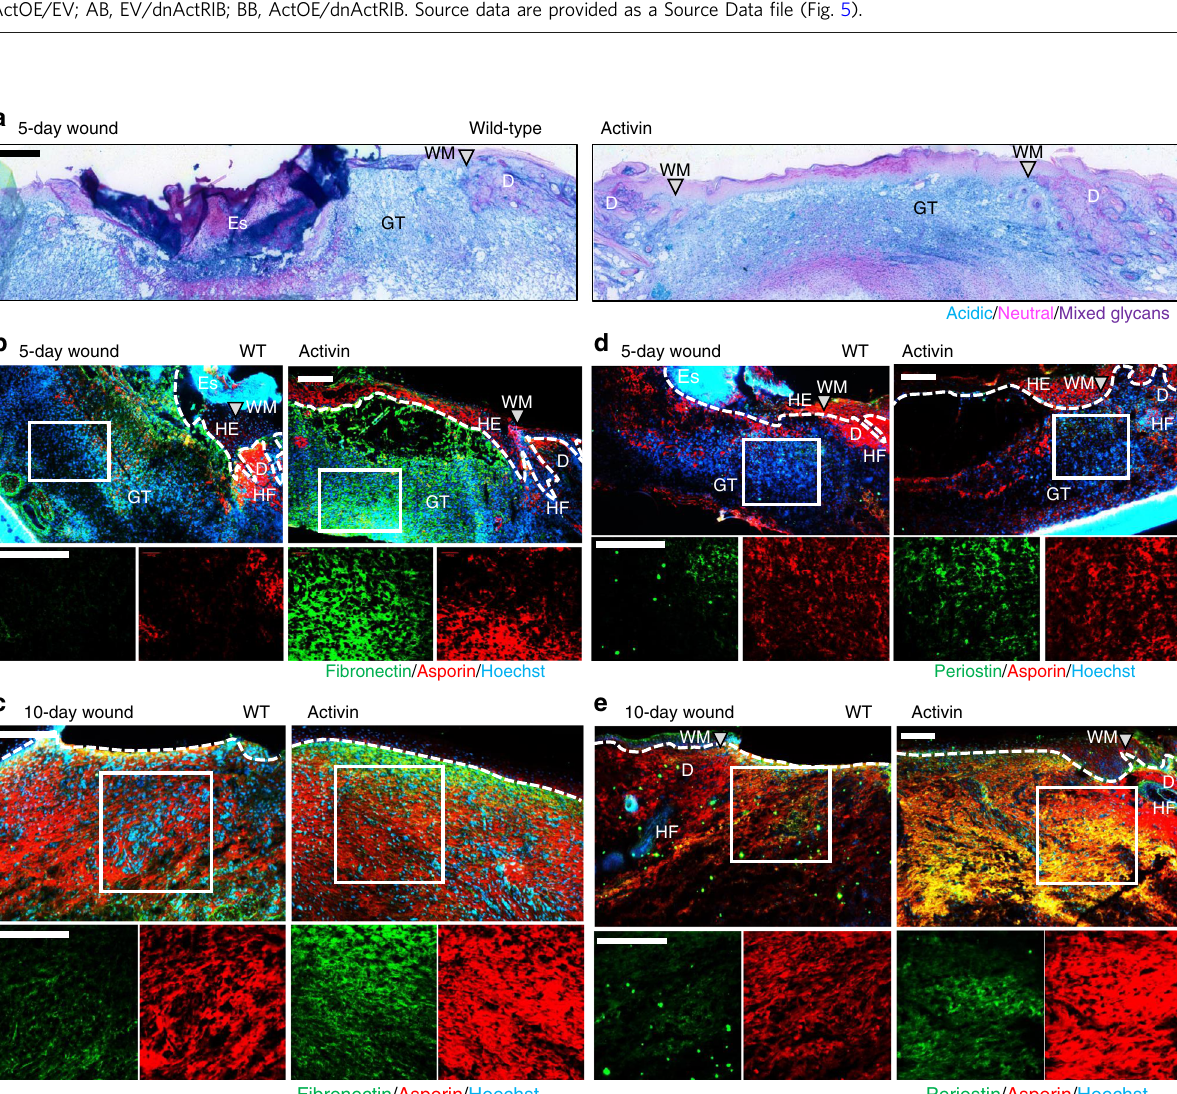
Fig. 5 Activin regulates pro- fi brotic ECM deposition by fi broblasts. a – d HaCaT keratinocytes transduced with lentiviruses allowing Dox-inducible overexpression of INHBA (ActOE) or empty vector (EV) were co-cultured with murine immortalized fi broblasts (GFP-expressing) transduced with lentiviruses allowing Dox-inducible expression of dnActRIB or with EV-transduced fi broblasts for 7 days in 1% or 10% FBS. Co-cultures were stained for collagen type I ( a , b ), periostin, and asporin ( c , d ). The experiment was repeated twice with similar results. Representative photomicrographs of ECM staining for each group. Bar graphs show quanti fi cation of the percentage of the stained area on whole co-culture coverslips. Scale bars: 1000 μ m. n = 3. e , f Representative high magni fi cation photomicrographs of collagen type I ( e ) and asporin ( f ) staining of ActOE/EV and ActOE/dnActRIB co-cultures in the presence of 1% or 10% FBS. GFP-positive fi broblasts are shown (green); nuclei were counterstained with DAPI (blue). Scale bars: 100 μ m. g , h GFP-expressing fi broblasts were sorted from GFP-negative HaCaT keratinocytes after 8 days co-culture, and gene expression was analyzed by qRT-PCR relative to RPL27 for keratinocytes ( g ) or Rps29 for fi broblasts ( h ). n = 3. The experiment was repeated twice with similar results. Graphs show mean±SEM and P values; mean expression levels in AA cultures were set to 1 in g and h ; one-way ANOVA and Tukey ’ s multiple comparison post hoc tests ( a – d , g , h ). All n numbers indicate biological replicates. AA, EV/EV;